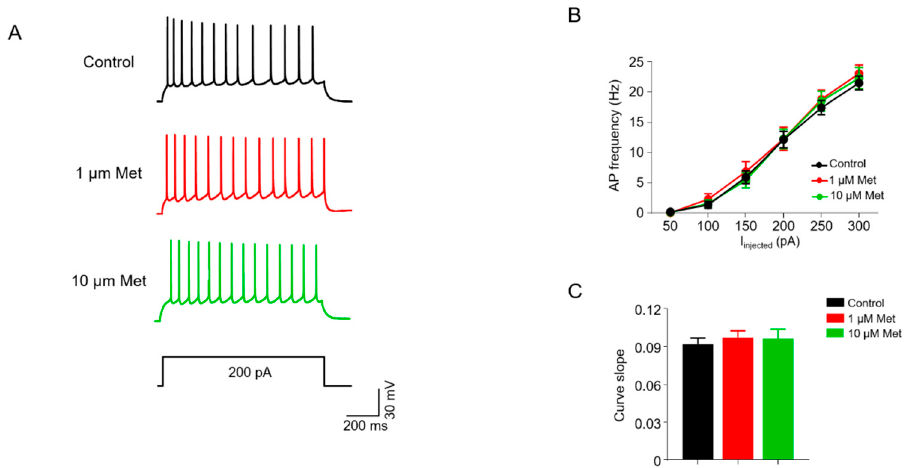
Figure 4. Met does not affect neuronal excitability in CA1 hippocampal pyramidal neurons. ( A ) Representative traces of spikes evoked by injecting 200 pA depolarizing currents. Scale bar = 200 ms, 30 mV. ( B ) Firing rate plotted against increasing injected depolarizing currents. Control, n = 14 neurons / 4 mice; 1 µ M Met, n = 15 neurons / 5 mice; 10 µ M Met, n = 16 neurons / 5 mice; F(2,252) = 0.5951, p = 0.5523; two-way ANOVA. ( C ) Comparisons of the curve slope in B. F(2,42) = 0.1984, p = 0.8208, control (0.092 ± 0.005) versus 1 µ M Met (0.097 ± 0.005), p = 0.8278; control (0.092 ± 0.005) versus 10 µ M Met (0.096 ± 0.008), p = 0.8704; 1 µ M Met (0.097 ± 0.005) versus 10 µ M Met (0.096 ± 0.008), p =